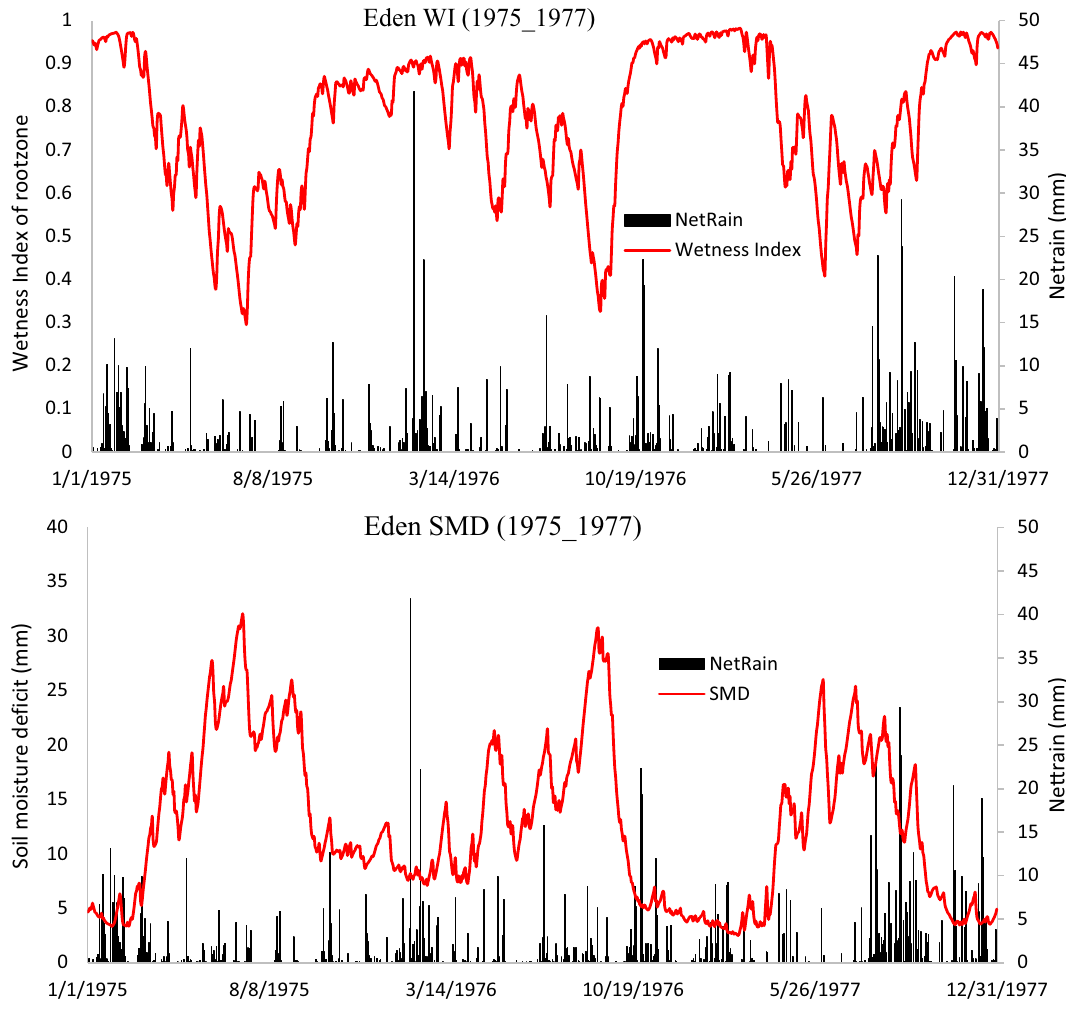
Fig. 11 Eden wetness index (Top) and soil moisture deficit (Bottom) for the years